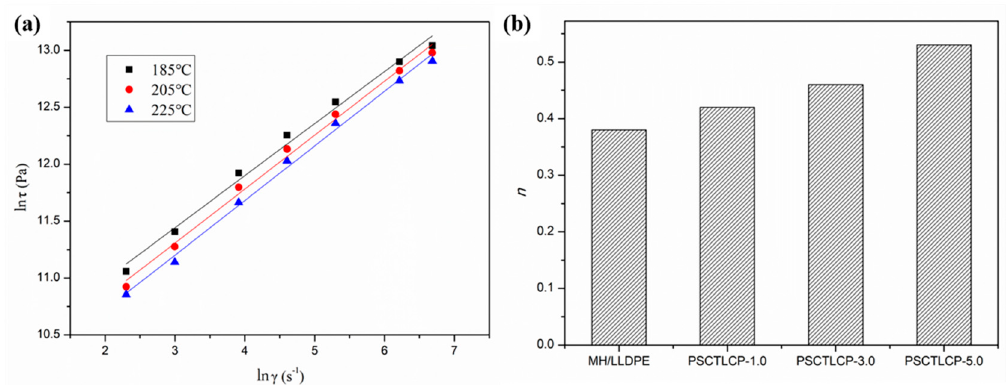
Figure 8. ( a ) Shear stress versus shear rate of PSCTLCP-1.0, ( b ) n values of MH/LLDPE/PSCTLCP composites.